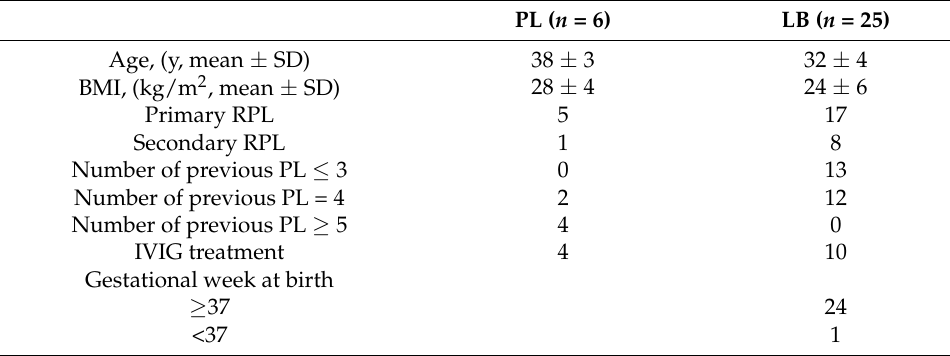
Table 2. General characteristics of the study